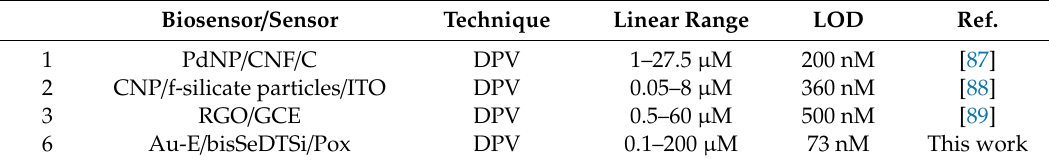
Table 3. Comparison of biosensors and sensors for DA detection.